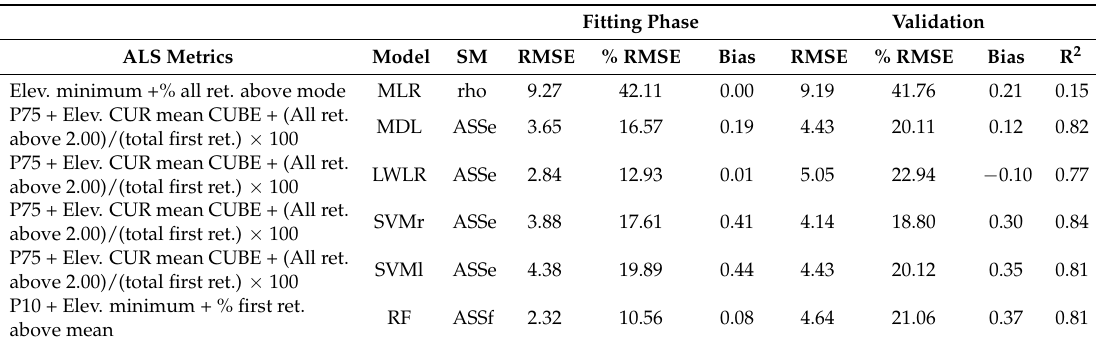
Table A5. Summary of the G models using 2016 ALS data. Validation results in terms of RMSE (m 2 ha − 1 ), %RMSE, and bias (m 2 ha − 1 ) and R 2 . SM refers to selection method; Step. stands for Stepwise both and forward; SVMr. refers to support vector machine with radial kernel; SVM l. refers to support vector machine with linear kernel; ret. refers to returns.